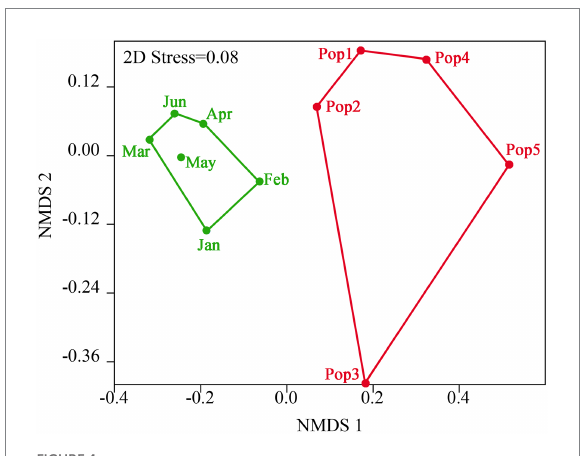
FIGURE 4 Norrmetric multidimensional scaling (NMDS) represents based on genetic diversity indexes of D. sinensis population in Lake Chaohu. Blue group represents six modern groups during January and June. Red group represents five historic groups in the 1–15 cm sedimentary layers.